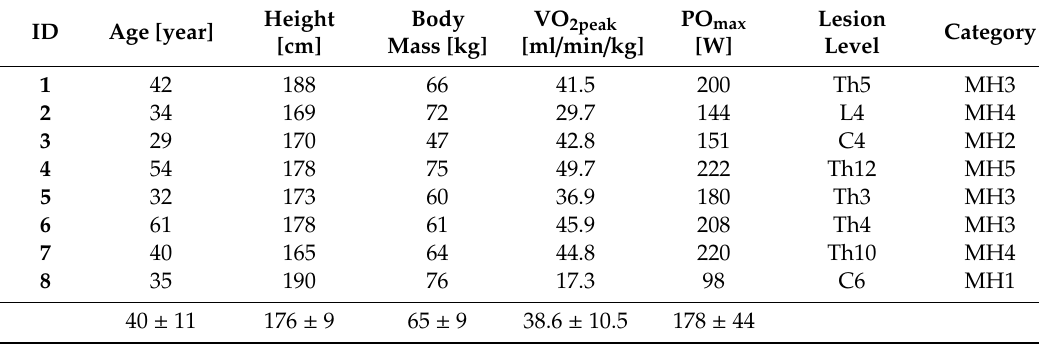
Table 1. Characteristics of the eight